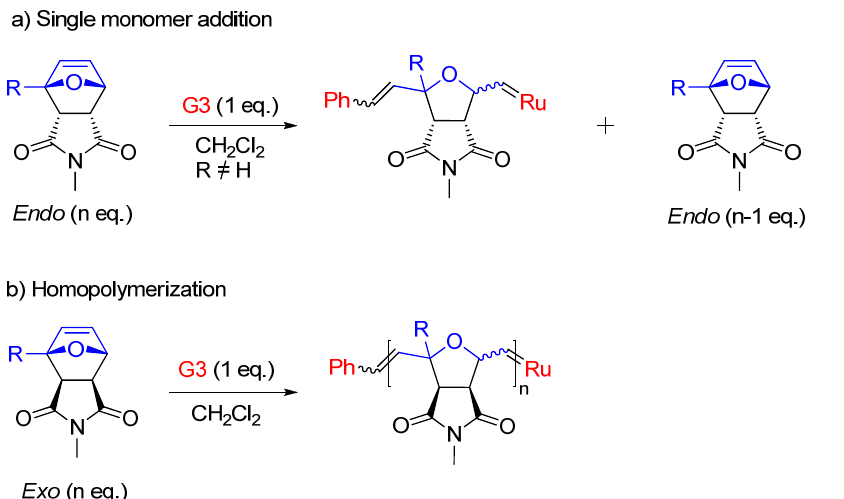
Scheme 2. Different reactivities of endo ( a ) and exo ( b ) furan-derived oxanorbornanes in Ru-catalyzed ring-opening metathesis polymerization. R = H, Me, n -propyl or n -pentyl. G3 = third generation Grubbs catalyst.